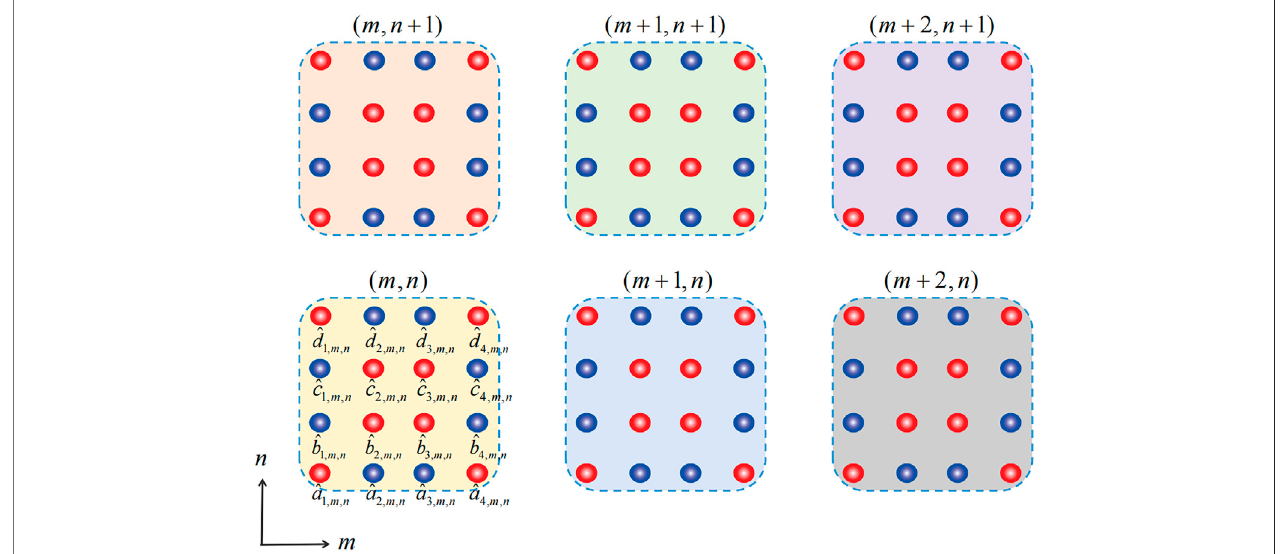
FIGURE 3 | The unit cells, labeled with ( m , n ), of our coinless DTQW in the two-dimensional lattice. Each unit cell has 16 sublattices, which are labeled as { ^ a (